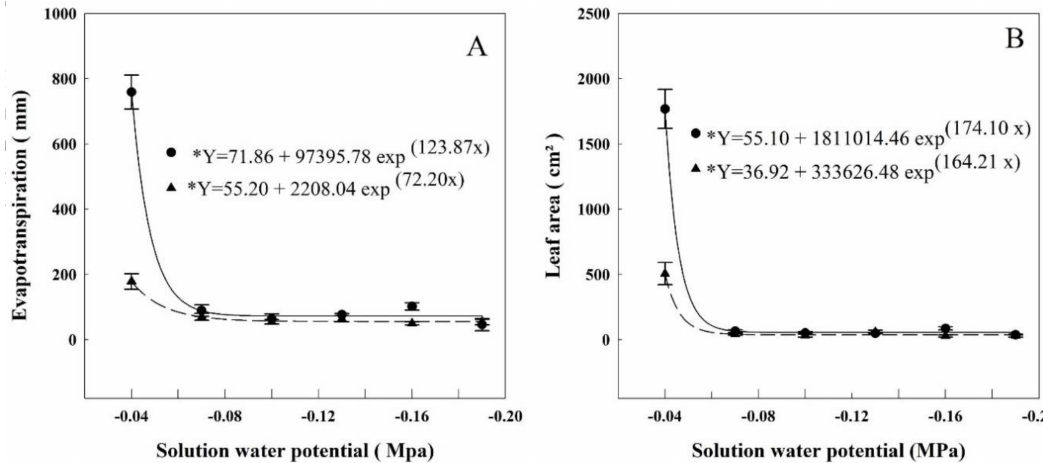
Figure 1. Evapotranspiration ( A ) and leaf area ( B ) of rice plants grown at different solutions with different water potentials. The error bars represent the standard error. * p -value < 0.01; • = HET; (cid:78) = LET.